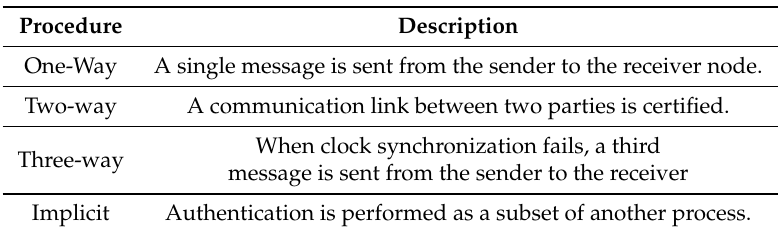
Table 2. Available authentication